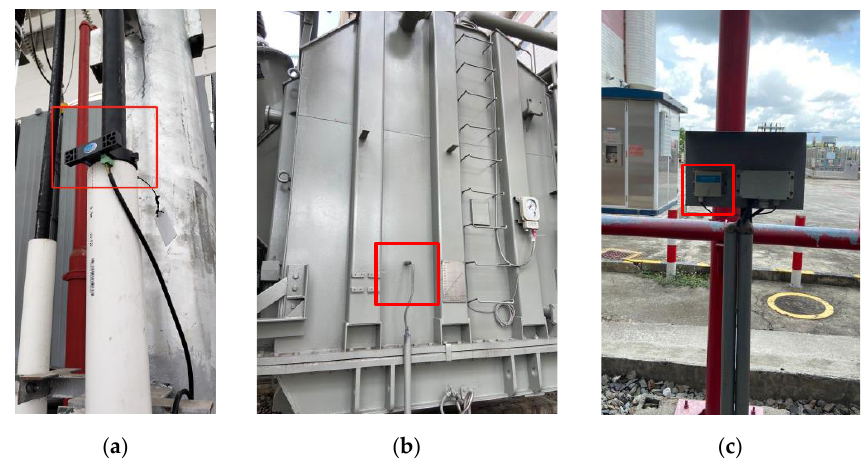
Figure 3. The installation mode of sensors: ( a ) neutral DC monitoring sensor; ( b ) vibration sensor; ( c ) noise sensor.